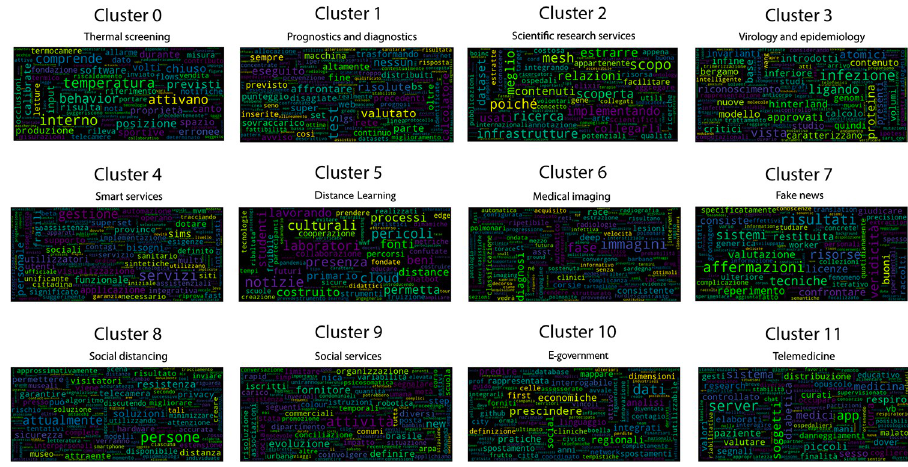
Fig 31. Tag-cloud of clusters for